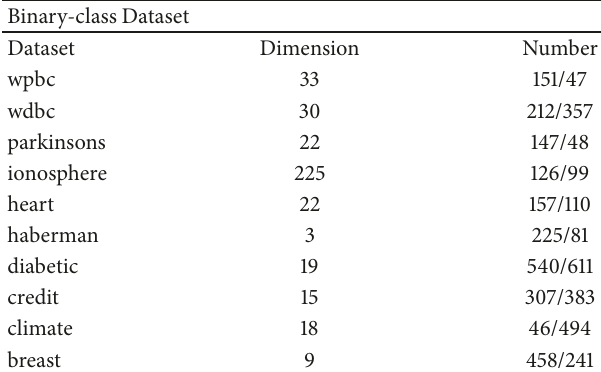
Table 1: Notations of UCI